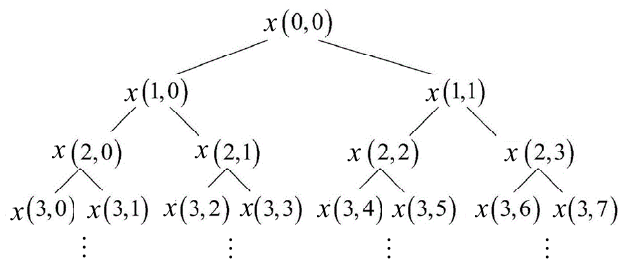
Figure 1. The structure of a wavelet packet decomposition tree.